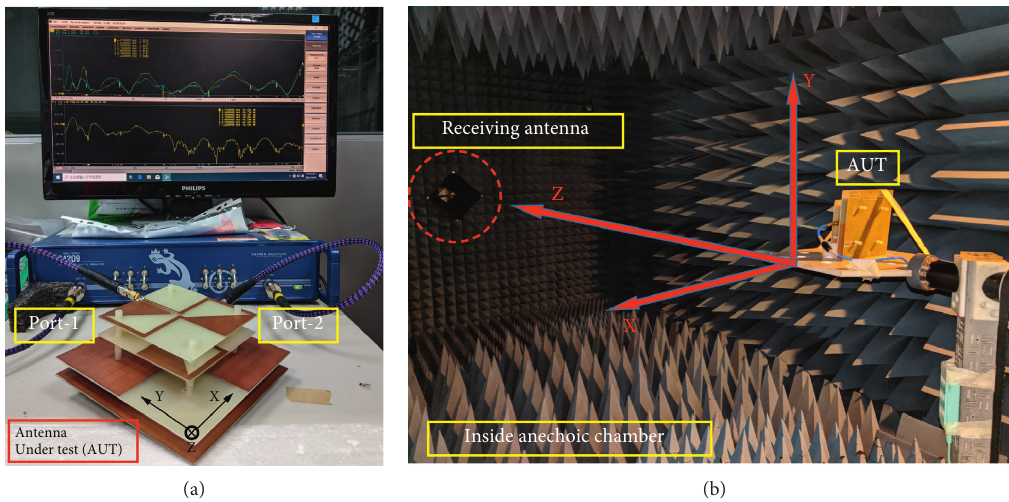
Figure 9: Photo of experimental measurement for (a) VSWR and |S